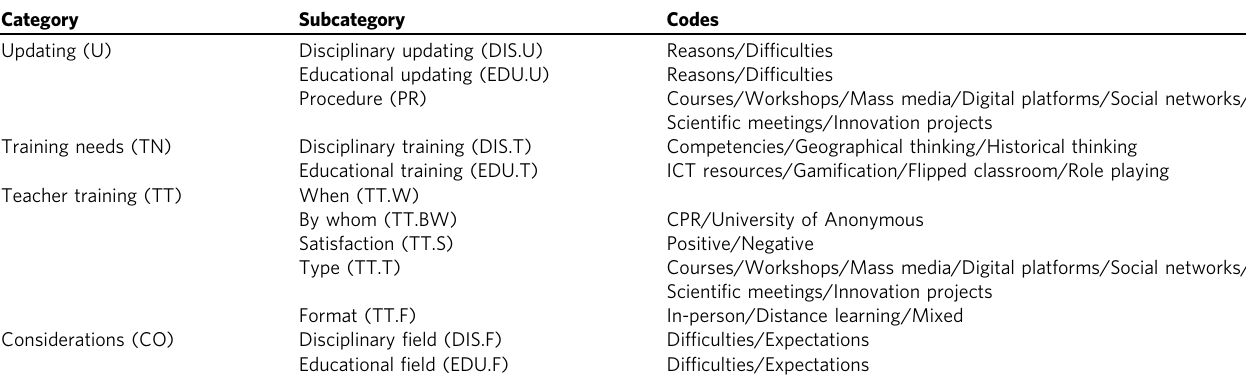
Table 4 Categories, subcategories and code of the interview. Category Subcategory Codes Updating (U)